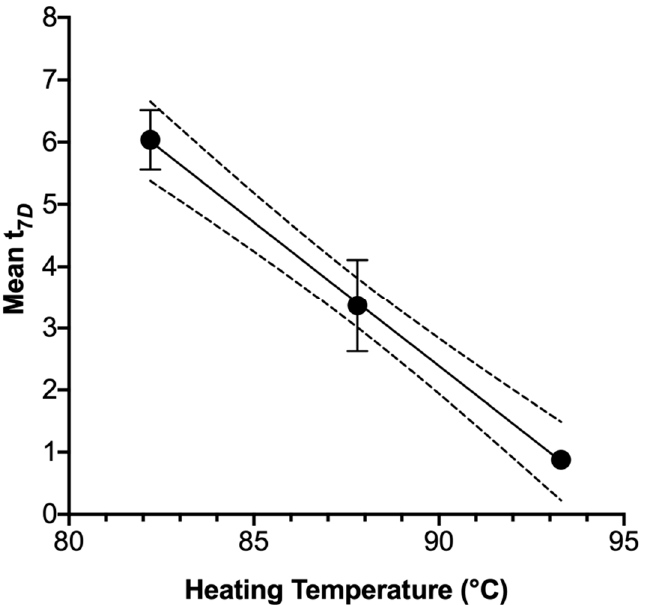
Figure 5. Least squares means of time required to achieve a 7.0 log 10 -cycle inactivation (t 7 D ) for Salmonella enterica heated in whole chicken blood to differing target temperatures. Symbols depict means from three identically completed replicates ( N = 3); error bars depict one standard error ( p = 0.001; pooled standard error = 0.73). Dashed lines depict 95% confidence limit boundaries.